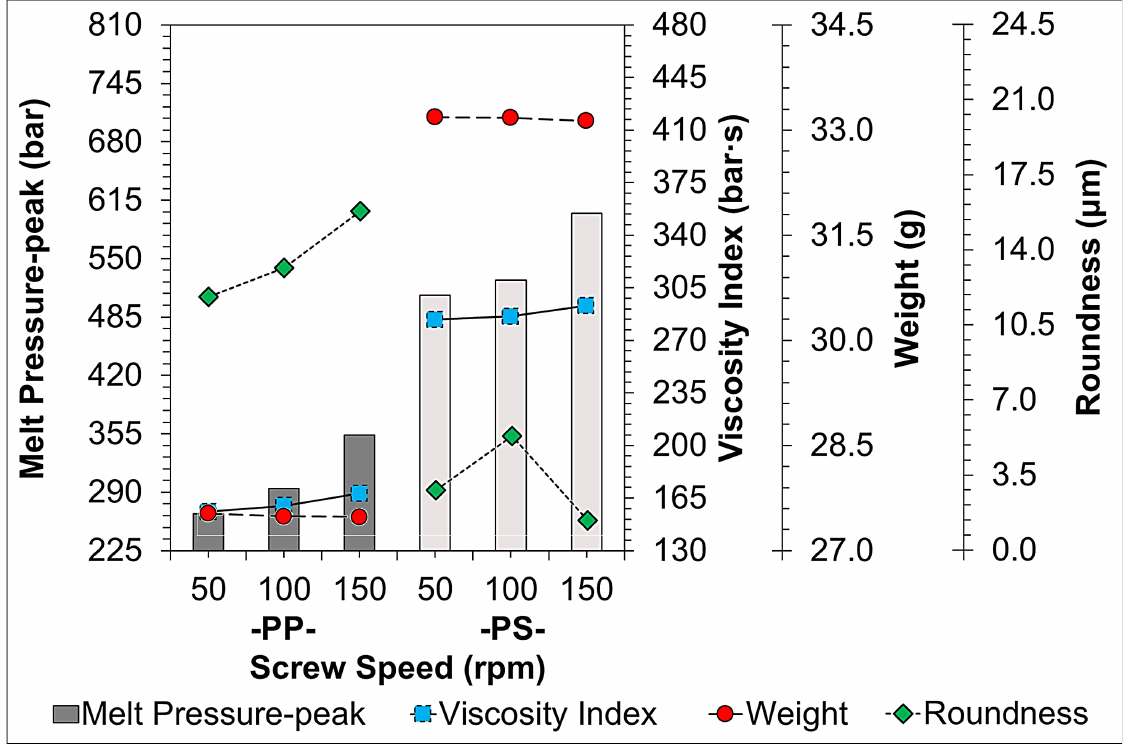
Figure 11. Trend-diagram of the effect of screw speed on melt pressure-peak (bar-graph), calculated viscosity index (continuous-line), and its sample weight (chain-line)/roundness (dotted-line).